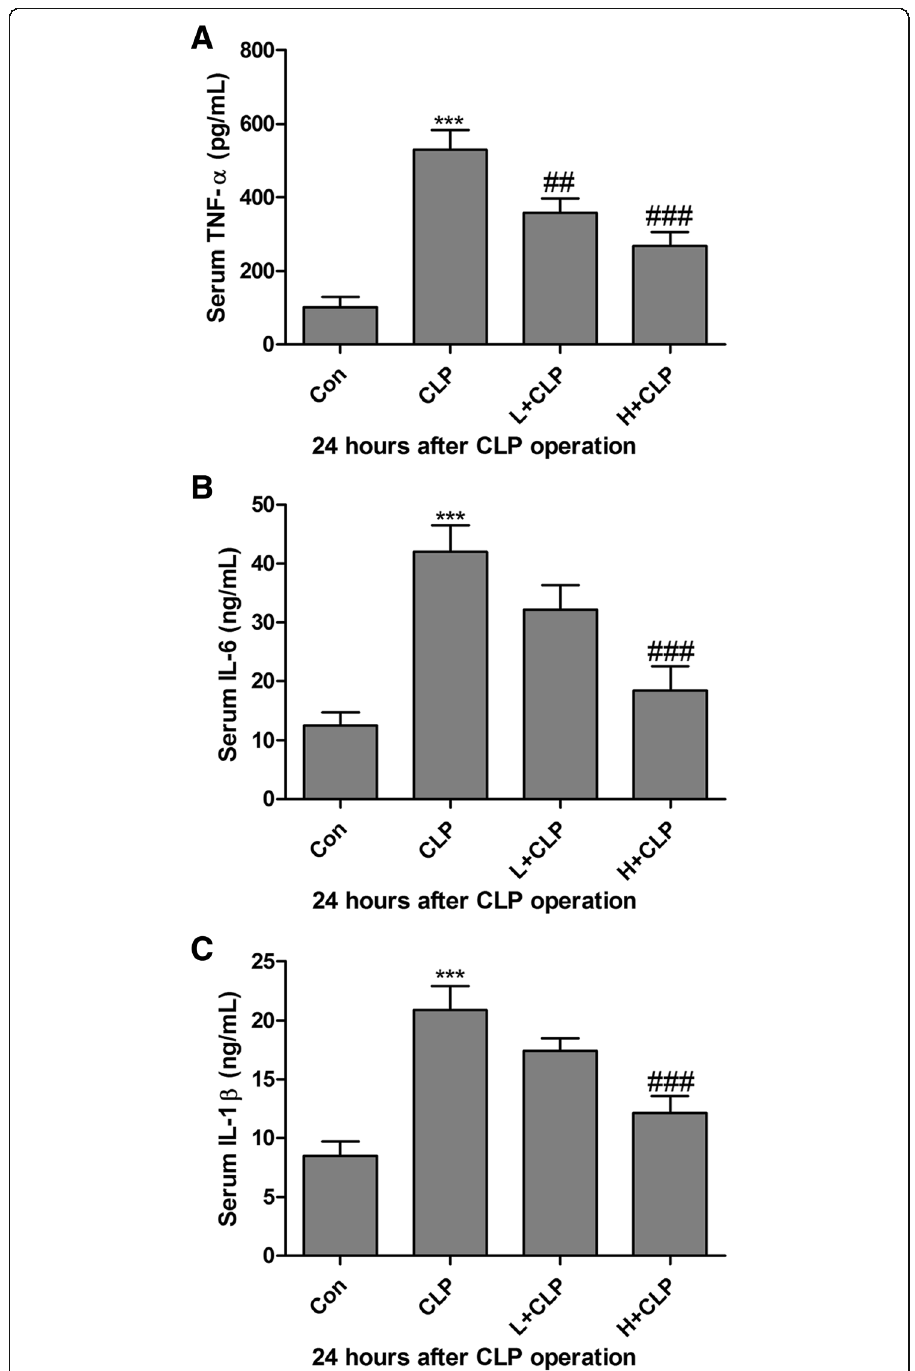
Fig. 3 Honokiol inhibits serum inflammatory cytokines in septic mice. Serum levels of TNF- α ( a ), IL-6 ( b ) and IL-1 β ( c ) were detected using mouse bioactive ELISA assay in CLP-induced septic mice. Values are expressed as mean ± SEM, n = 10 in Con or H + CLP group and n = 8 in CLP or L + CLP group. *** P < 0.001, versus control group; ## P < 0.01 and ### P < 0.001 versus CLP single treatment